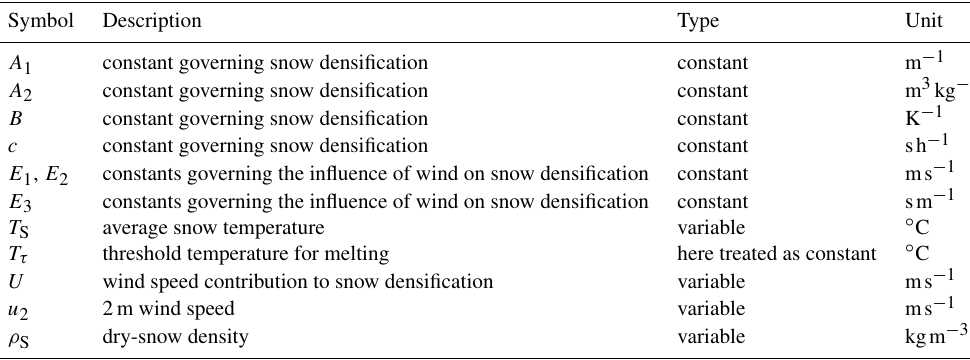
Table B6. List of the symbols related to snow densification